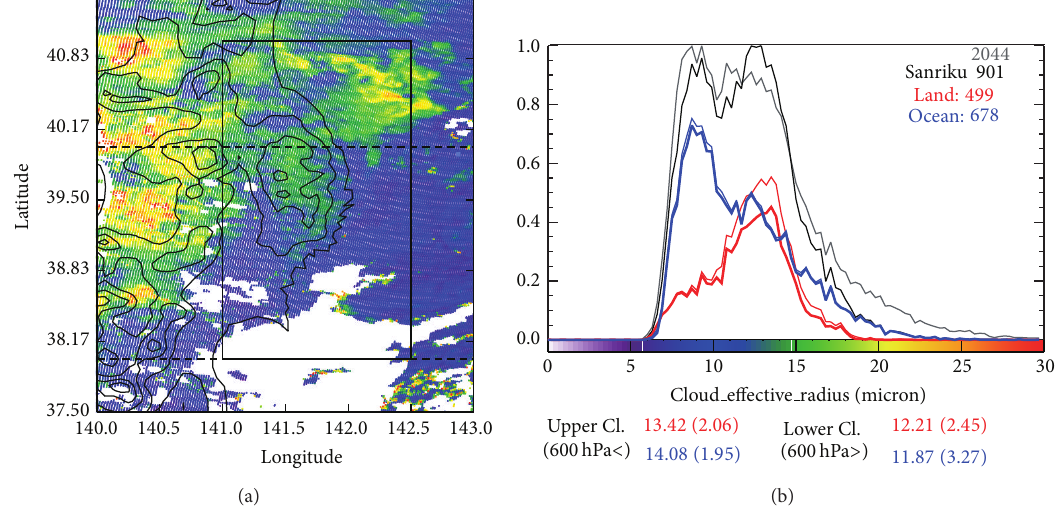
Figure 12: Same as Figure 8 but at 0150 UTC July 16, 2003.